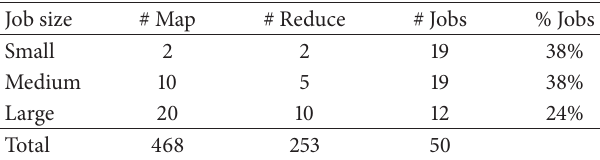
Table 4: Distribution of job